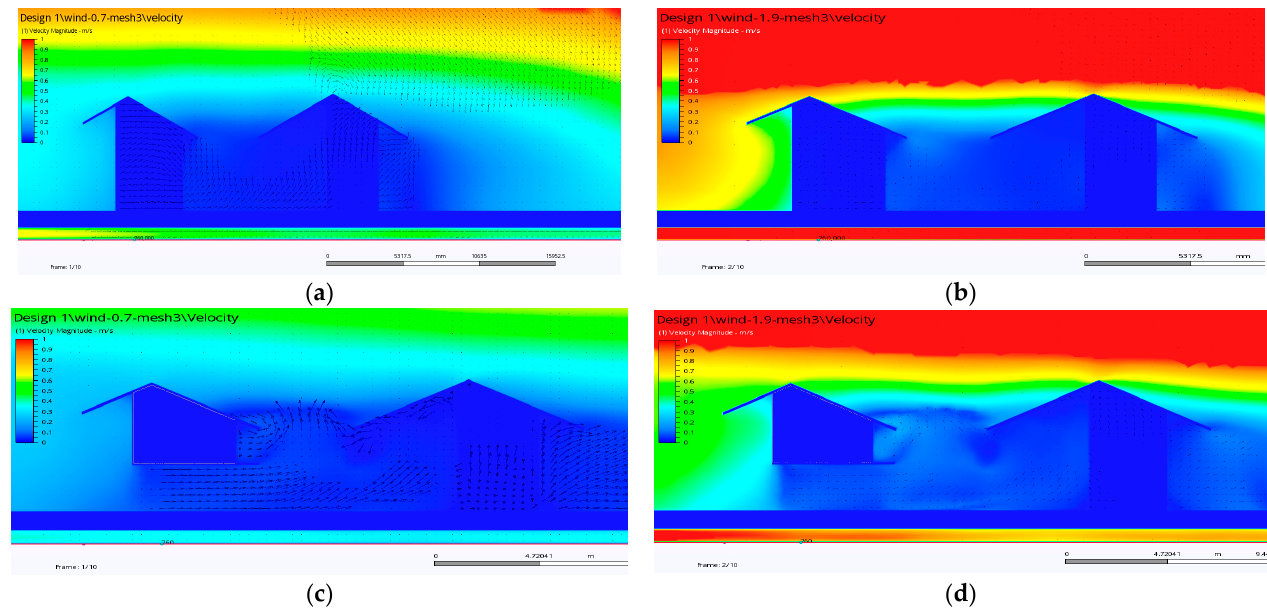
Figure 22. Airflow pattern and wind velocity by wind effect only: ( a ) enclosed courtyard in winter, ( b ) enclosed courtyard in summer, ( c ) open courtyard in winter, and ( d ) open courtyard in summer.